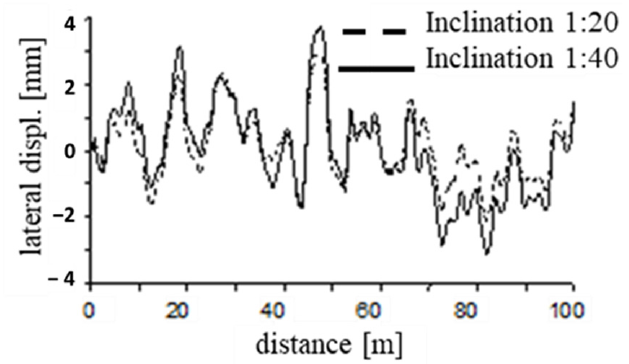
Figure 15. Wheelset lateral displacements for various rail inclinations. Table 1. The statistical values of lateral forces (in [N]) impacting the wheel at various rail inclinations. Inclination Average Value Standard Deviation